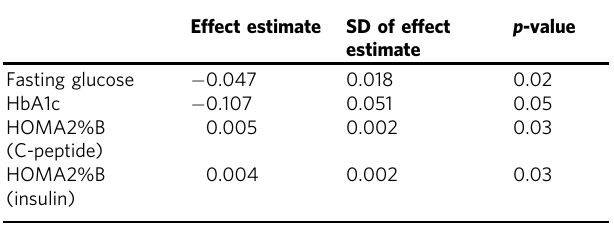
Table 1 RAB3IP transcript is misregulated in islets from (pre-)diabetic donors.